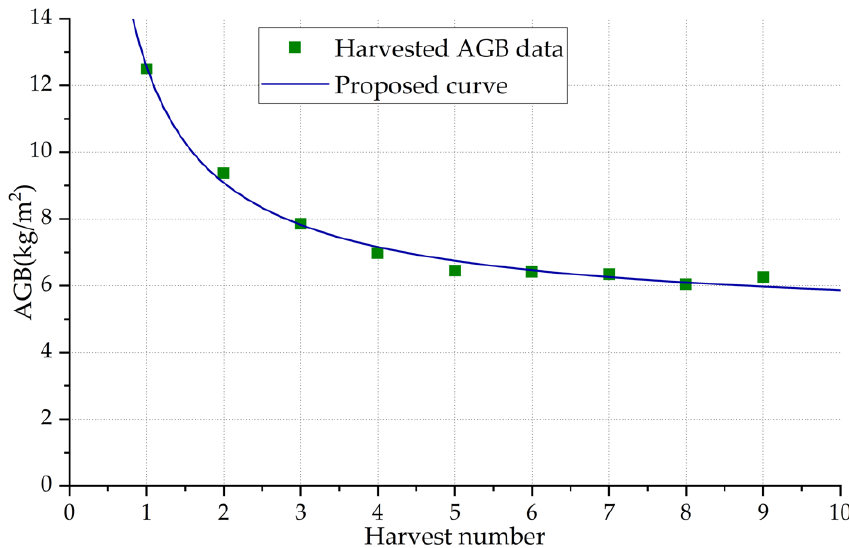
Figure 6. Harvested AGB and a proposed fitting curve.